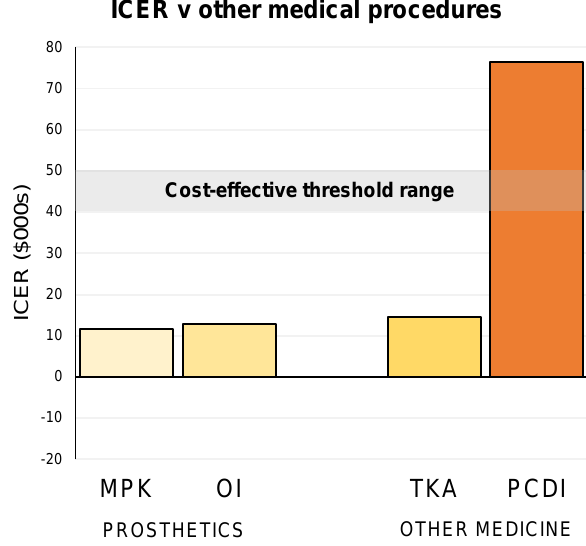
Figure 2 : Incremental Cost-Effectiveness Ratio comparison of Microprocessor Prosthetic Knees (MPK), Osseointegration (OI), Total Knee angioplasty (TKA), and Prophylactic cardioverter defibrillator implantation (PCDI). All values in 2016 USD9,11. (Diagram from Blatchford